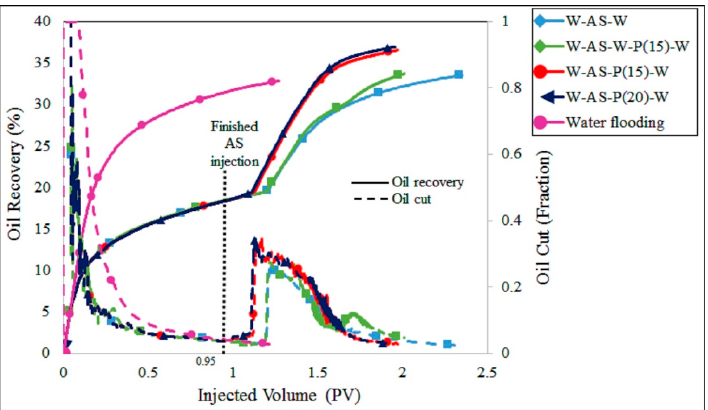
Figure 5. Oil production performance of water flooding and the sequences of the (AS) group. The employments of AS solution right after the preflushing water does not improve the oil recovery significantly compared to water flooding even when using a buffering polymer solution.